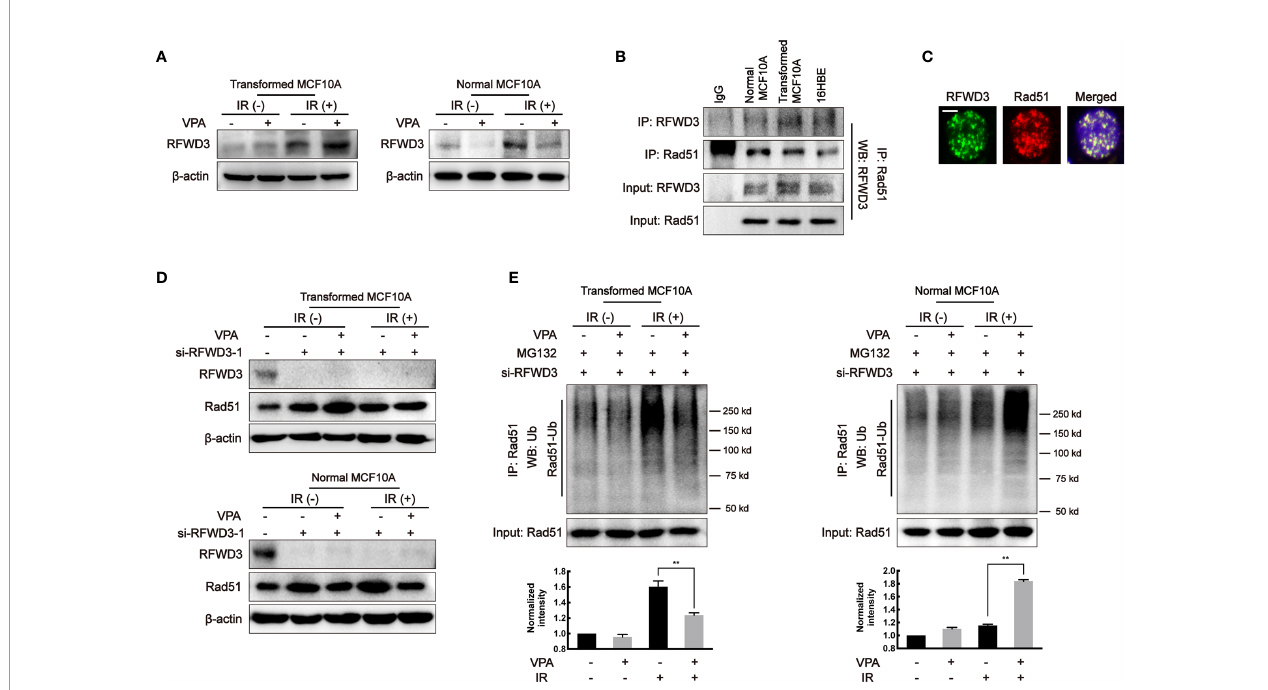
FIGURE 4 | RFWD3-dependent Rad51 ubiquitination is involved in the VPA-mediated bidirectional effect. (A) RFWD3 protein expression was detected with VPA and IR treatment. (B) The interaction between RFWD3 and Rad51 proteins was detected by protein beads containing Rad51 antibody through Western blot. (C) The foci formation of RFWD3 and Rad51 in this paired cell was detected at 6 h post-8 Gy IR. Co-localization of RFWD3 and Rad51 proteins was shown in the fi gure. The scale bar represented as 10µm. (D) siRNA was designed to abolish the function of RFWD3 and the expression of Rad51 under those treatments was detected by Western blot. (E) Ubiquitination of Rad51 on transformed and normal MCF10A cells after RFWD3 depletion was detected by Western blot. Bands in the graphs were quanti fi ed by ImageJ software (Wayne Rasband). Each data point in the graph was from three independent experiments (mean ± SD); P -values were calculated by t-test (** P < 0.01).